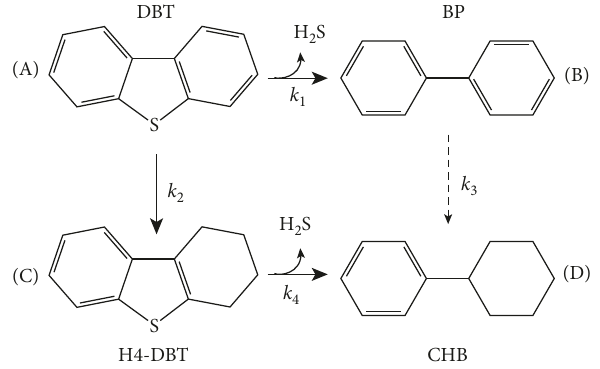
Scheme 1: Reaction scheme for HDS of